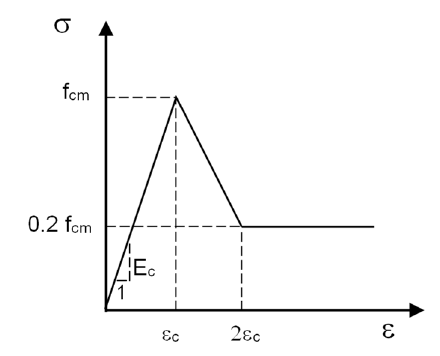
Figure 5. HSC constitutive model.